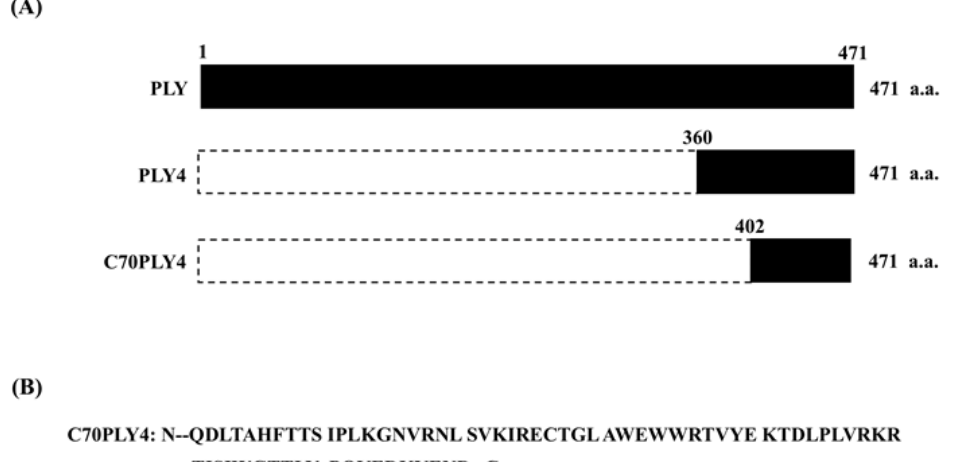
Figure 1. Schematic representation of the various PLY fragments. ( A ) The full-length PLY (1-471 amino acid residues) and fragments thereof, including a fragment of domain 4 of PLY (PLY4, 360-471 amino acid residues) and the C-terminal 70 amino acids of PLY4 (C70PLY4, 402-471 amino acid residues). ( B ) The amino acid sequence of C70PLY4.